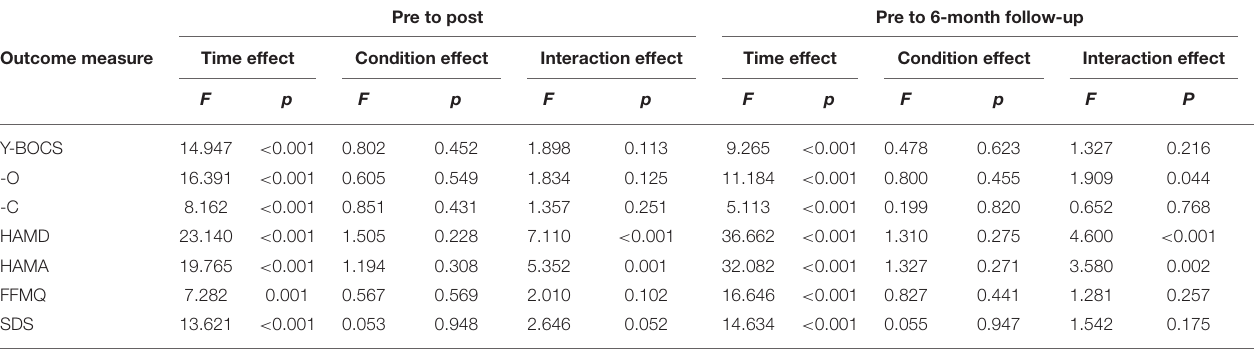
TABLE 4 | Results of ANOVA of repeated measures between